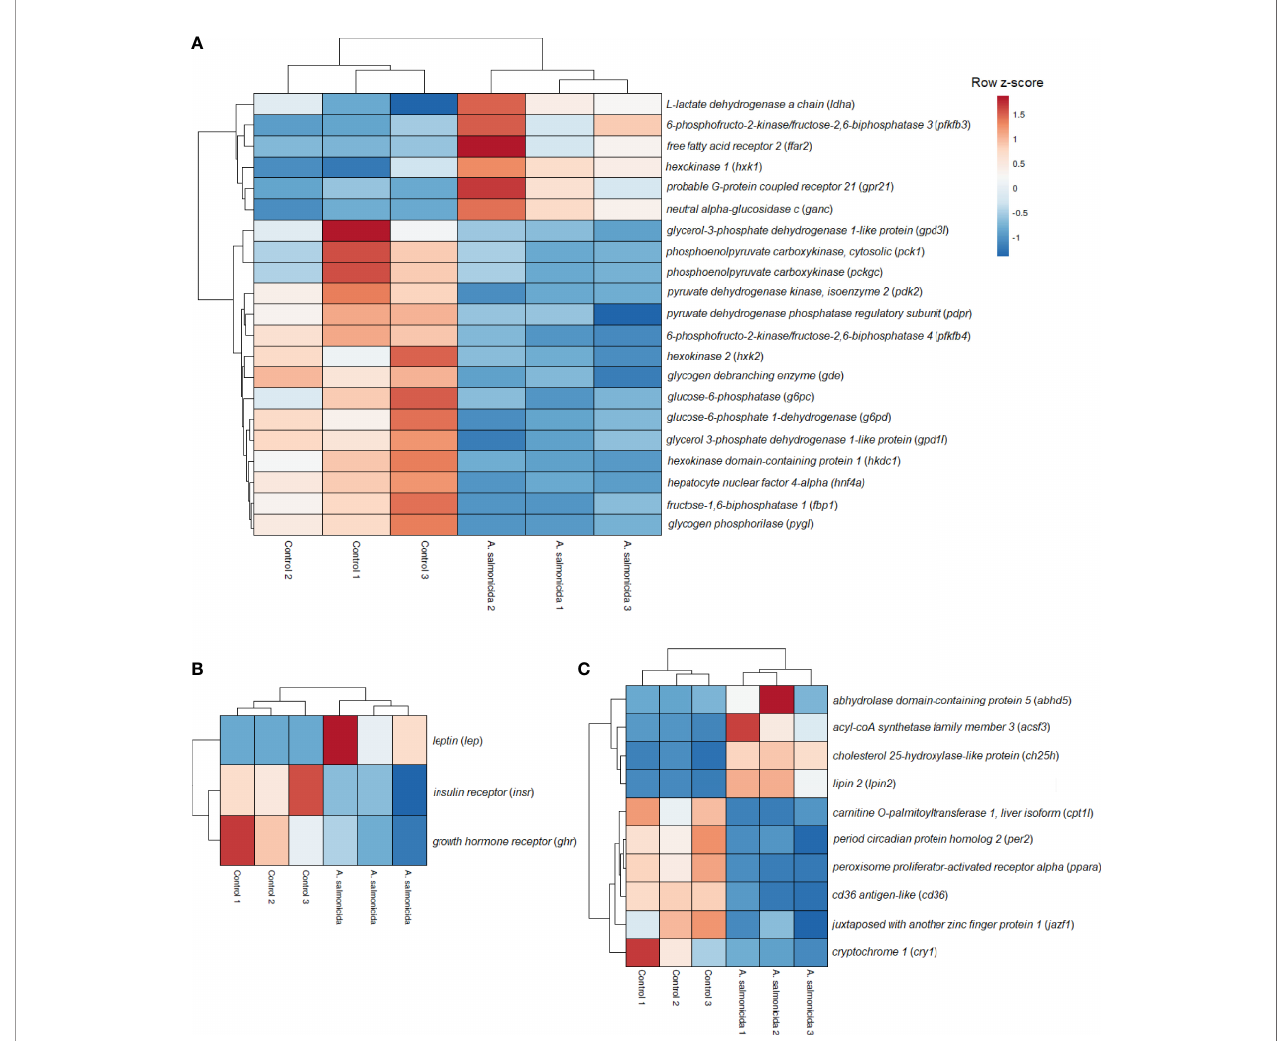
FIGURE 4 | Analysis of the carbohydrate and lipid metabolism-related genes modulated in head kidney samples from A salmonicida -infected turbot. Heatmaps representing the TPM values of (A) carbohydrate metabolism-related genes, (B) hormones and hormone receptors and (C) lipid metabolism-related genes differentially expressed in turbot head kidney at 24 hpi with the bacteria A salmonicida compared to the uninfected controls. The colour scale represents gene expression, ranging from blue (less expressed) to red